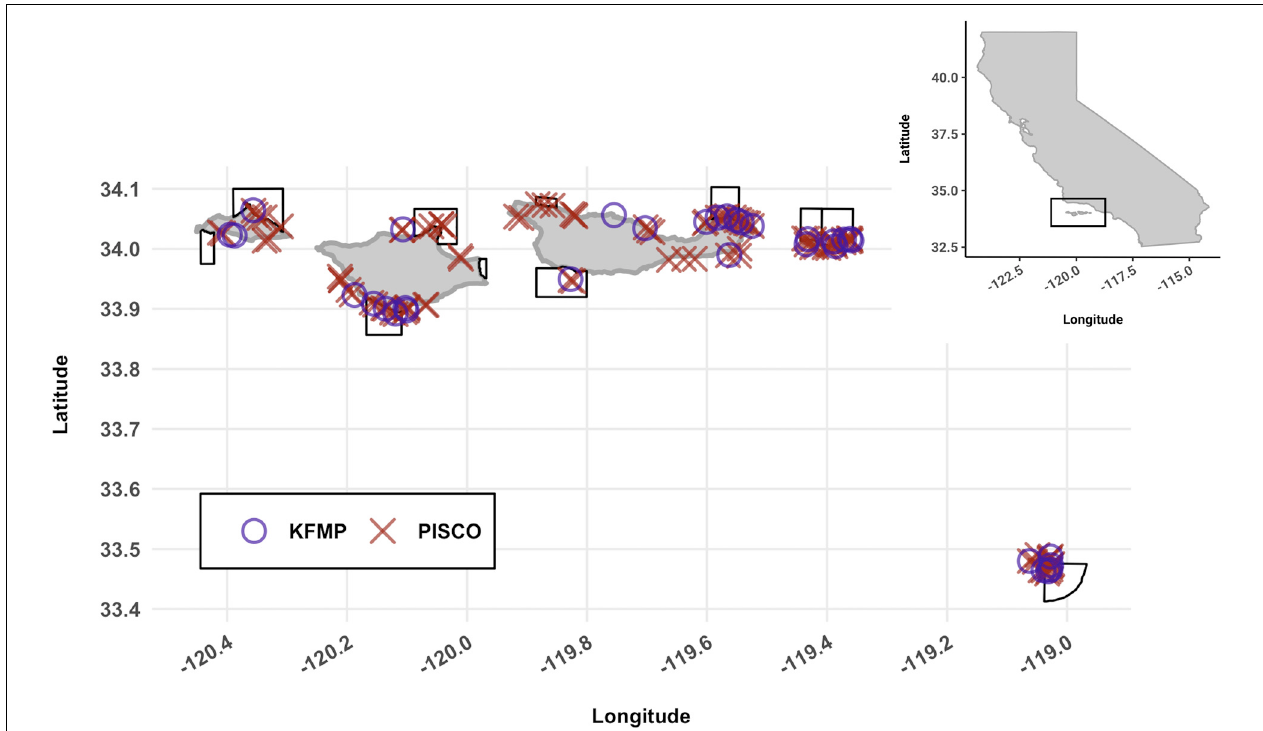
FIGURE 1 | Map of the study area, the Channel Islands National Park, CA, United States. All sites sampled between 2000 and 2016 are shown. Circles represent KFMP sites ( n = 33) and crosses represent PISCO sites ( n = 100). Black bordered polygons outline marine protected areas. Location within the state of California is show in the inset